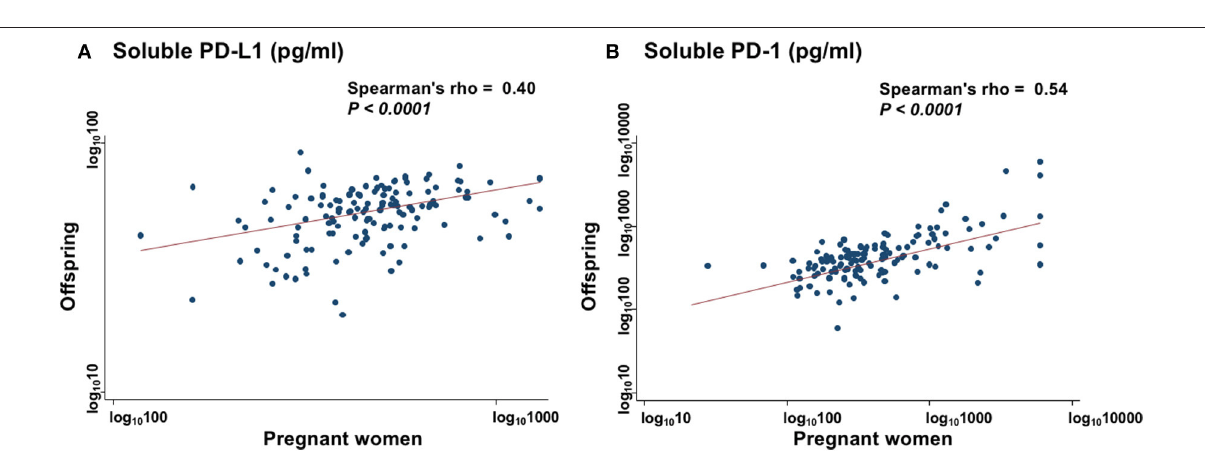
between sPD-L1 and sPD-1 levels in serum of PW and of